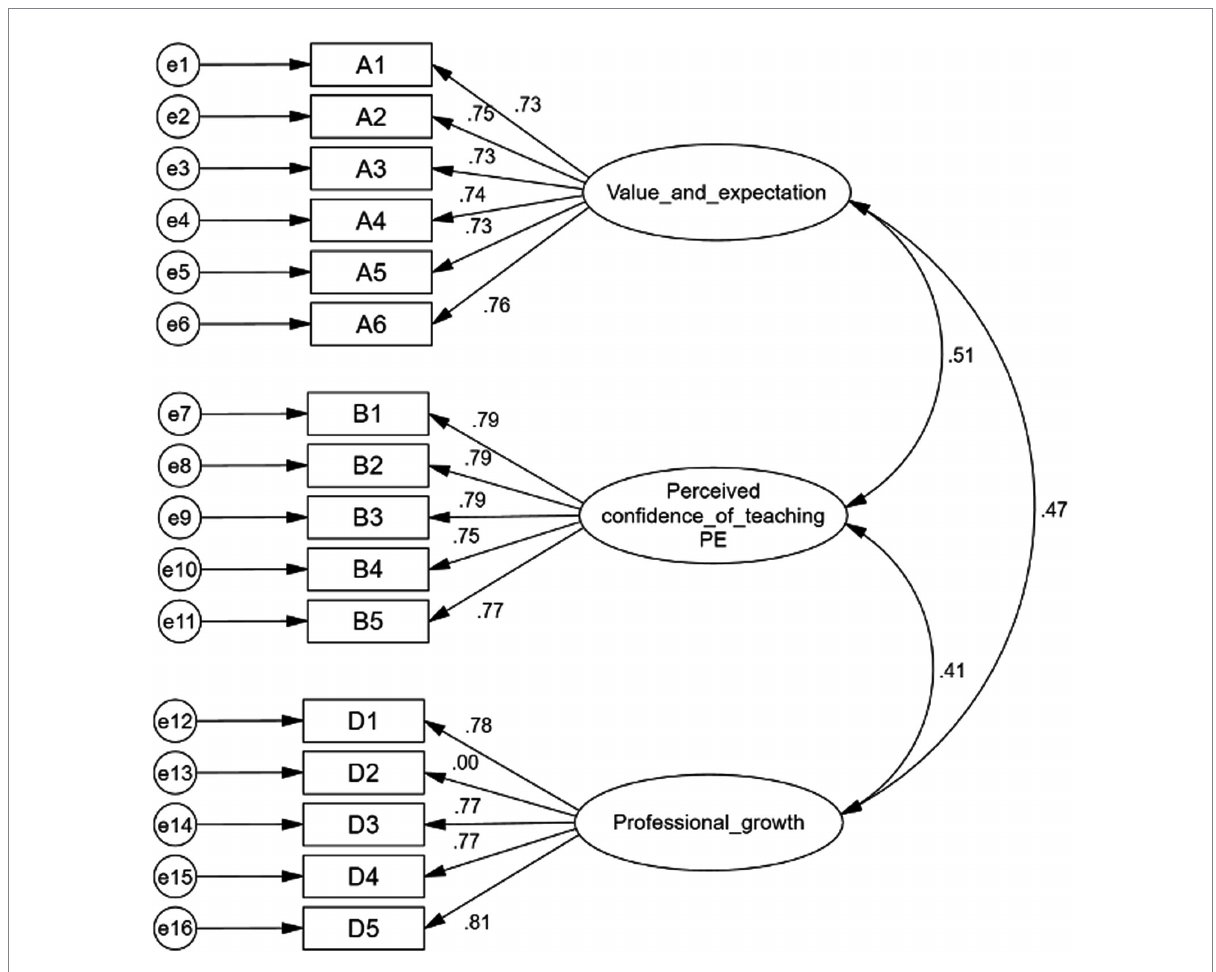
FIGURE 1 Original structure model of PPET-TI scale with four